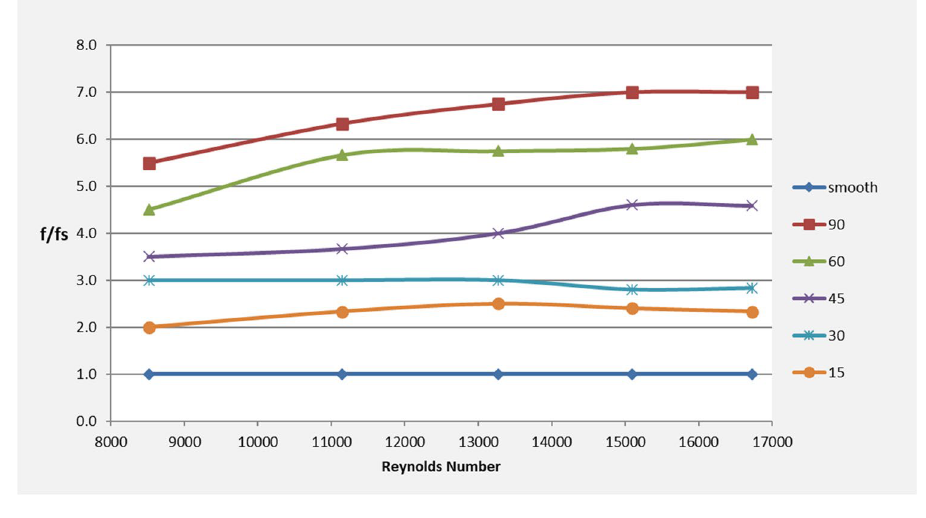
Fig. 9 Variation of Nu/Nus with Reynolds Number at P/D =